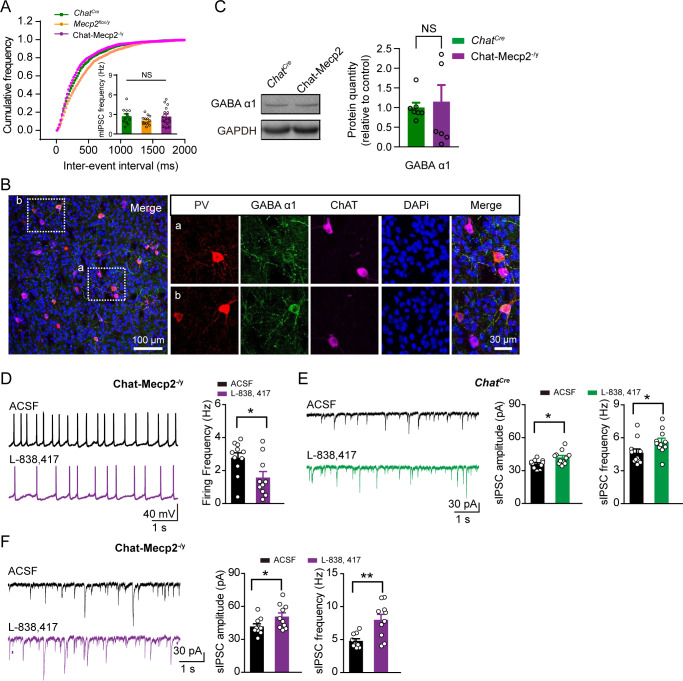
Depletion of MeCP2 Did Not Affect mIPSC Frequency of Cholinergic Interneurons, with Limited Expression of GABAA Receptor α1 Subunits in Cholinergic Interneurons within NAc, Related to Figure 3.(A) Cumulative distribution of mIPSC inter-event interval and average frequency of NAc cholinergic interneurons. P-values were calculated by one-way analysis of variance (ANOVA) with Bonferroni’s multiple comparisons test. F (2, 39)=1.535, p=0.2282. n = 12 neurons from four mice (ChatCre), 14 neurons from four mice (Mecp2flox/y), 16 neurons from four mice (Chat-Mecp2-/y). (B) Fluorescence images showing NAc sections stained for the PV, ChAT, GABAA receptor α1, and DAPI. (C) Immunoblotting of GABAA receptor α1 in NAc extracts prepared from ChatCre and Chat-Mecp2-/y mice. Each lane was loaded with 40 μg of protein, with GAPDH as loading control, and normalized to ChatCre levels. Data are means ± SEM. P-values were calculated by two-tailed unpaired t-test. t = 0.3411, df = 12, p=0.7390. n = 7 for ChatCre mice, seven for Chat-Mecp2-/y mice. (D Example traces and statistical results of spontaneous spiking recorded from cholinergic interneurons in NAc of Chat-Mecp2-/y mice. P-values were calculated by two-tailed unpaired t-test. t = 2.496, df = 19, p=0.0219. n = 11 neurons from three mice for ACSF, n = 10 neurons from three mice for L-838,417. (E) Example sIPSC traces and statistical results of amplitude and frequency recorded from cholinergic interneurons in NAc of ChatCre mice. P-values were calculated by two-tailed unpaired t-test. t = 2.688, df = 20, p=0.0141 for amplitude. t = 2.099, df = 20, p=0.0488 for frequency. n = 11 neurons from three mice for each group. (F) Example sIPSC traces and statistical results of amplitude and frequency recorded from cholinergic interneurons in NAc of Chat-Mecp2-/y mice. P-values were calculated by two-tailed unpaired t-test. t = 2.108, df = 18, p=0.0493 for amplitude. t = 3.536, df = 18, p=0.0024 for frequency. n = 10 neurons from three mice for each group. Data are means ± SEM. NS means no significance.